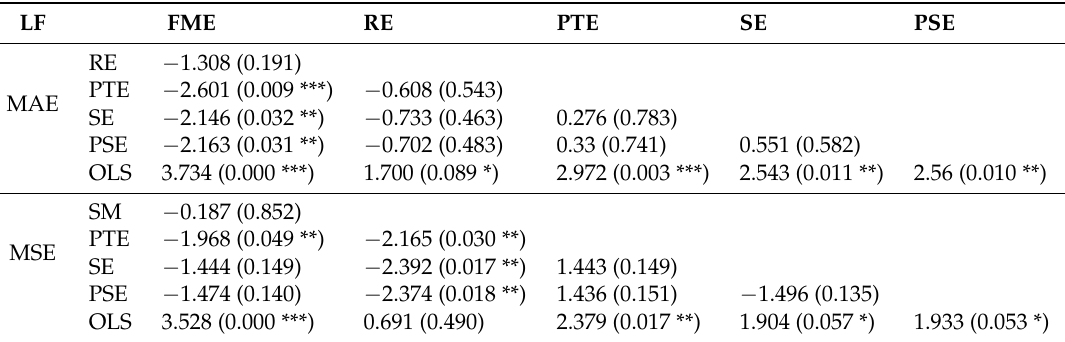
Table 12. Diebold–Mariano test for the forecasting